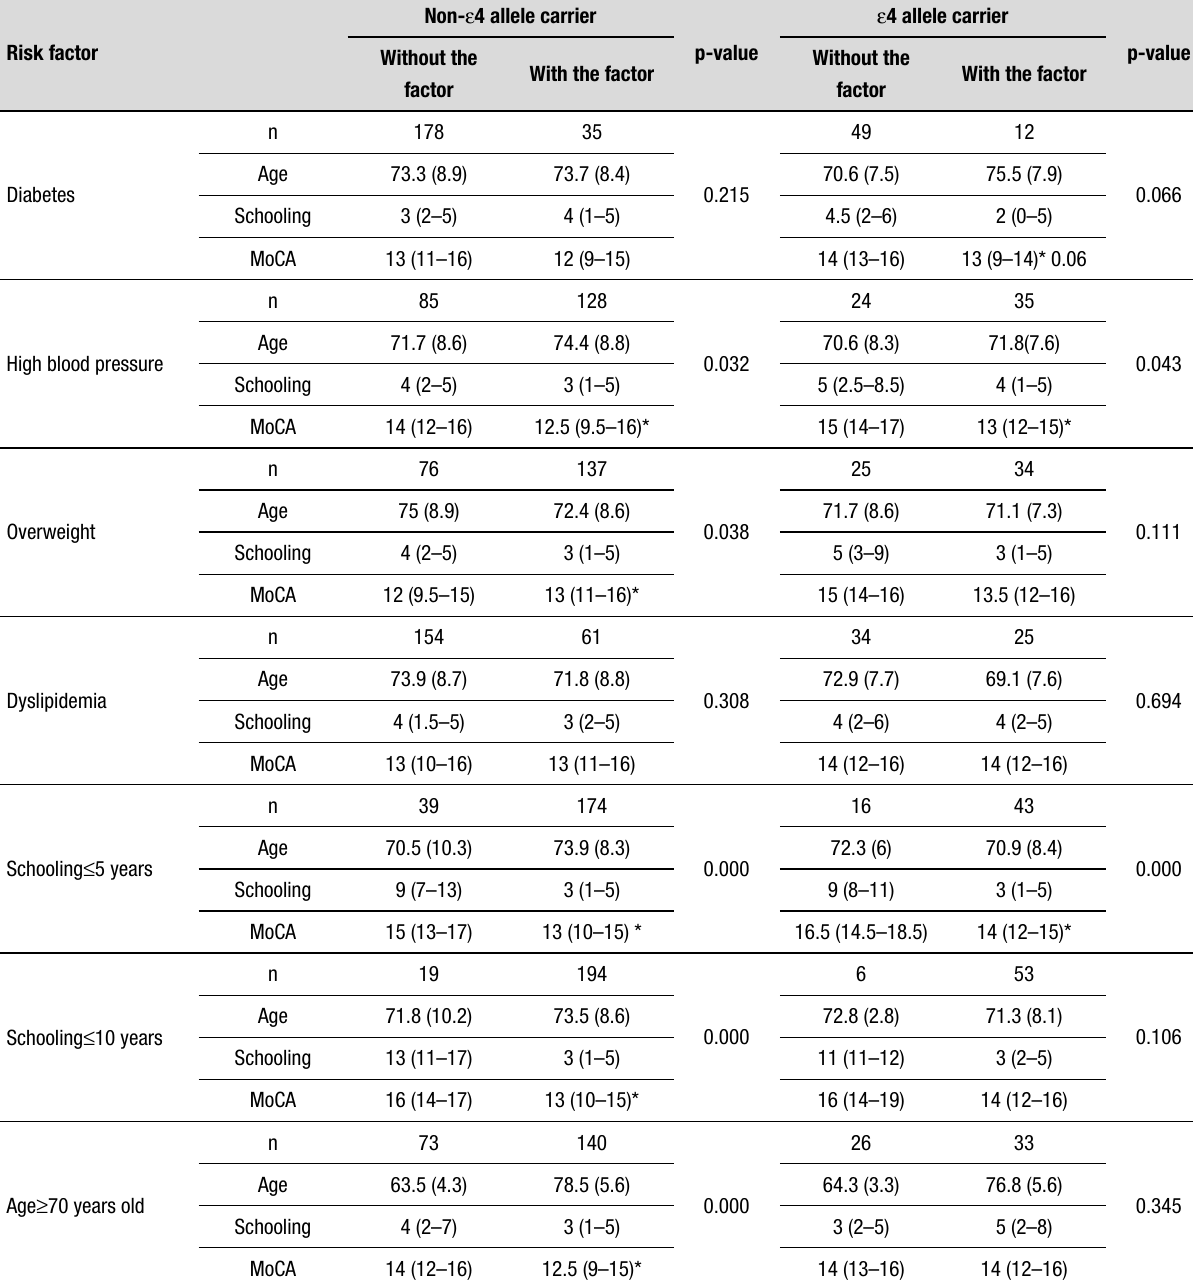
Table 4. Comparison of Montréal Cognitive Assessment test, by risk factors, between patients with dementia carriers and non-carriers of the allele ε 4. Risk factor